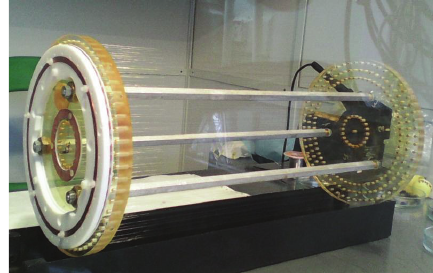
Figure 1: The central part of the